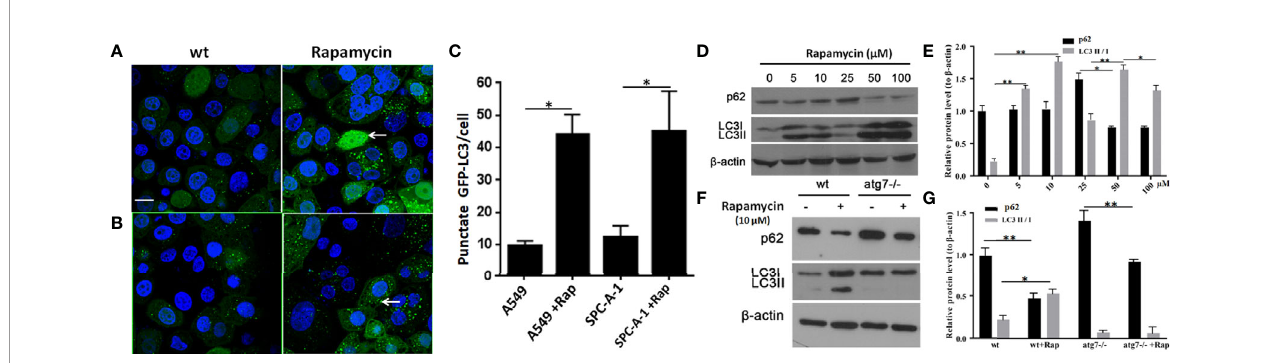
FIGURE 6 | Changes in detection of p62 and LC3 II/I protein upon induction or inhibition of autophagy. (A) In untreated wild type A549 cells, punctate GFP-LC3 (white arrow) was rare (left image) but increased signi fi cantly after exposure to rapamycin (10 m M/L) for 24 h (right image) by GFP-LC3 immuno fl uorescence microscopy. (B) Similar to wild type SPC-A-1 cells, punctate GFP-LC3 increased slightly after treatment with rapamycin. (C) Punctate GFP-LC3 positive cells were increased after rapamycin exposure both in A549 and SPC-A-1 cells. (D) p62 and LC3 II/I protein expression upon different concentrations of exposure to rapamycin for 24h. (E) Densitometric analysis of protein bands showing LC3 II/I protein expression increased from 5 m M/L to 10 m M/L and decreased from 50 m M/L to 100 m M/L, but p62 protein expression changes were not obvious. (F) Changes in detection of p62 and LC3 II/I protein upon autophagic gene 7 knockout (Atg7-/-). (G) Densitometric analysis of protein bands showing LC3 II/I protein expression almost disappeared after Atg7-/- knockout, but p62 protein expression decreased obviously both after autophagy induction by Rapamycin and autophagy inhibition by Atg7-/- knockout. Scale bar was 20 m m. wt, wild type A549 or SPC-A-1 cells; Rap, Rapamycin. *P < 0.05, **P < 0.01 .